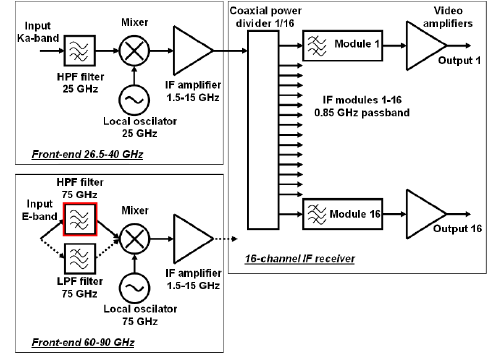
Figure 1. Upper: Block scheme of the ECE / EBW radiometer, taken from [4]